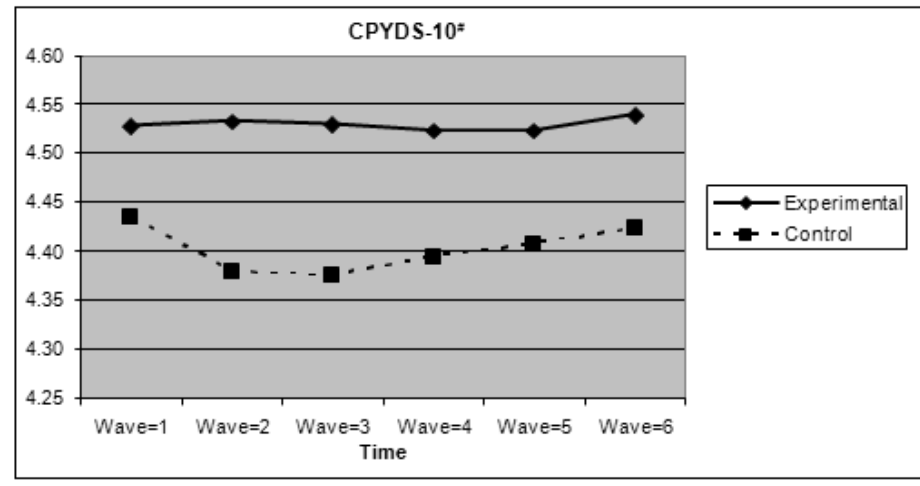
FIGURE 5. Growth trajectories of the experimental participants Δ and control participants using CPYDS-10 # as an outcome indicator. Δ Experimental participants who regarded the program as beneficial. # 10 Subscales of the Chinese Positive Youth Development Scale.